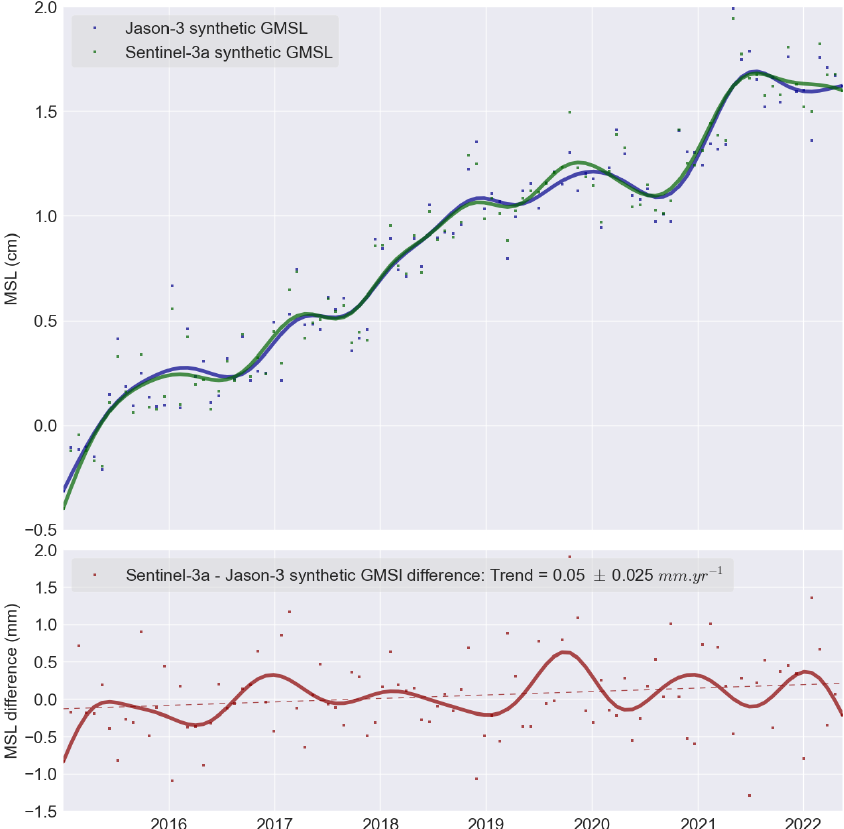
Figure 3. Long-term impact of changing from TOPEX “historical” to Sentinel-3a ground tracks on the global mean sea level evolutions.